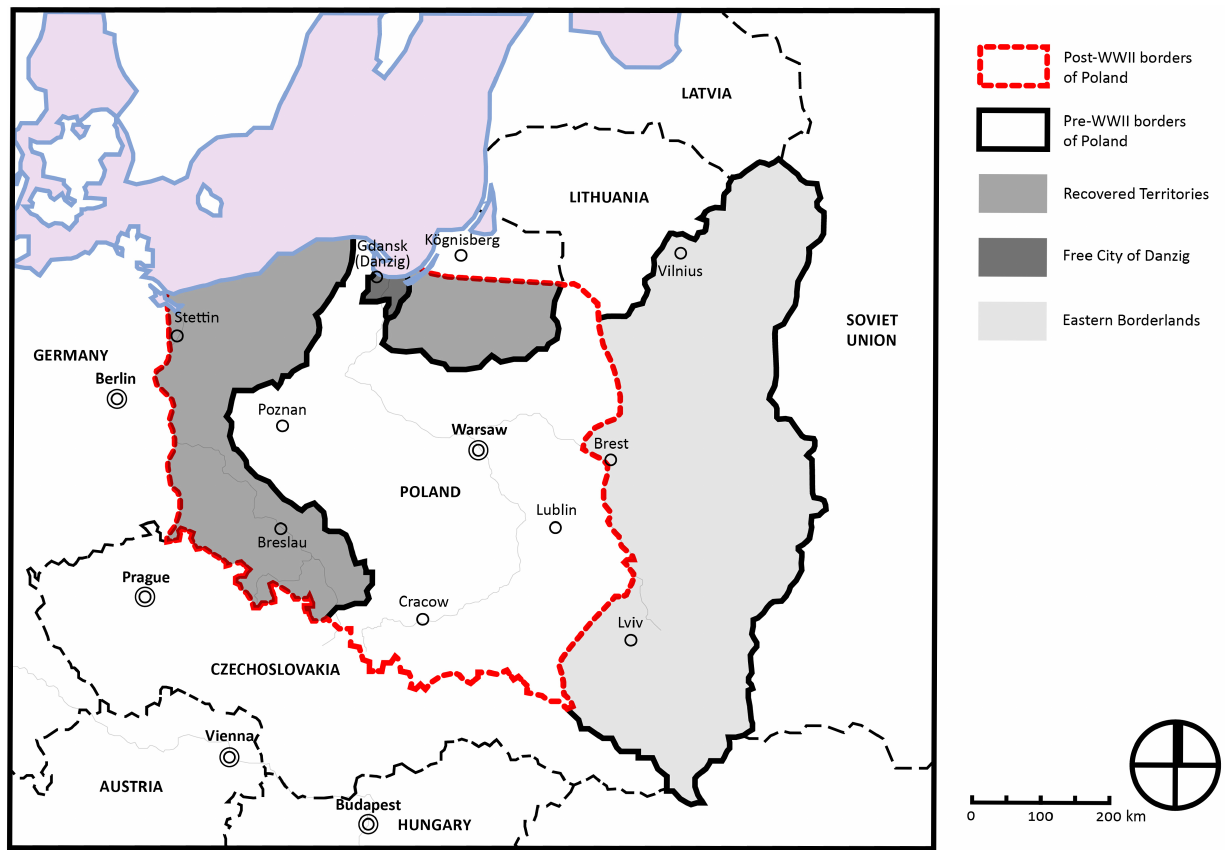
Figure 1. The shift of Polish borders after